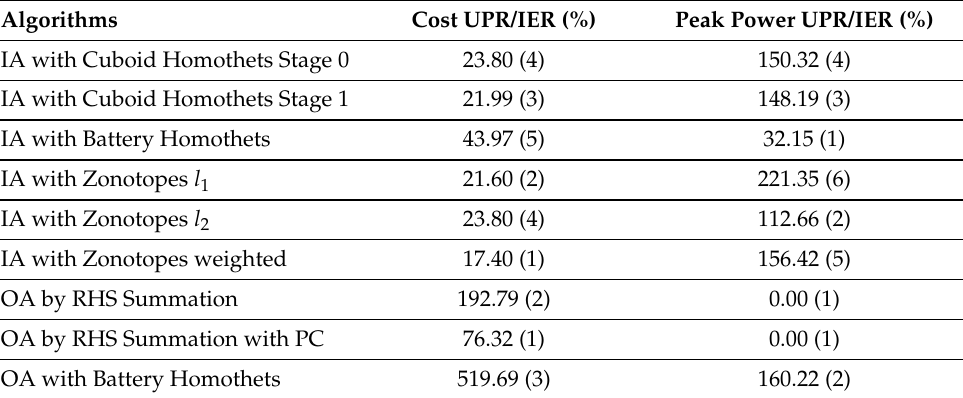
Table 6. Overall ranking: median overall quality criteria values for preselected approximations and N and M values, and in brackets, the rankings depending on approximation type (inner and outer) and objective